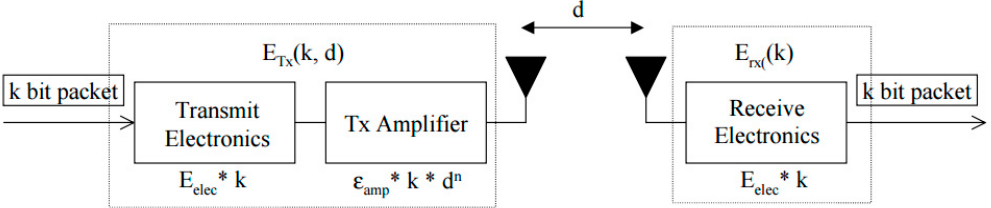
Figure 4. Radio Energy Dissipation Model.